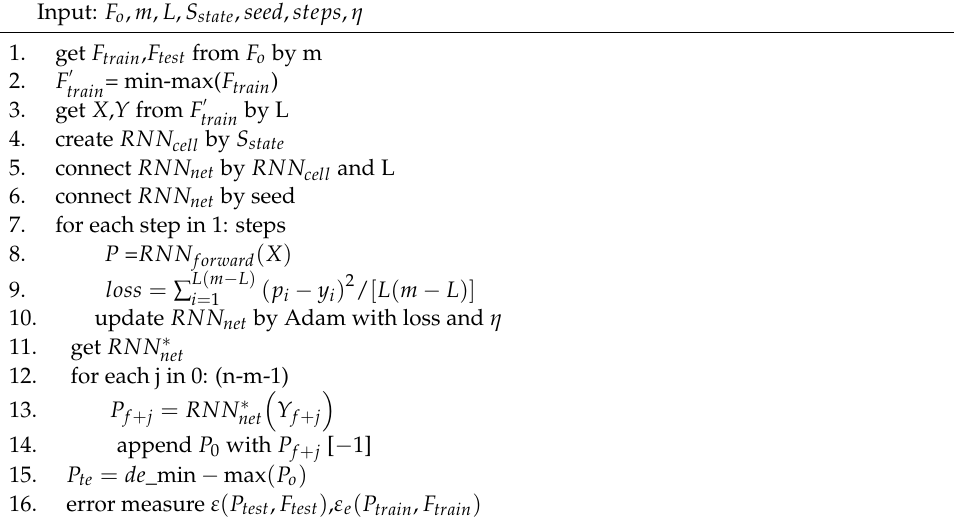
Algorithm 2. the training and prediction of a gas concentration prediction model for a working face based on the